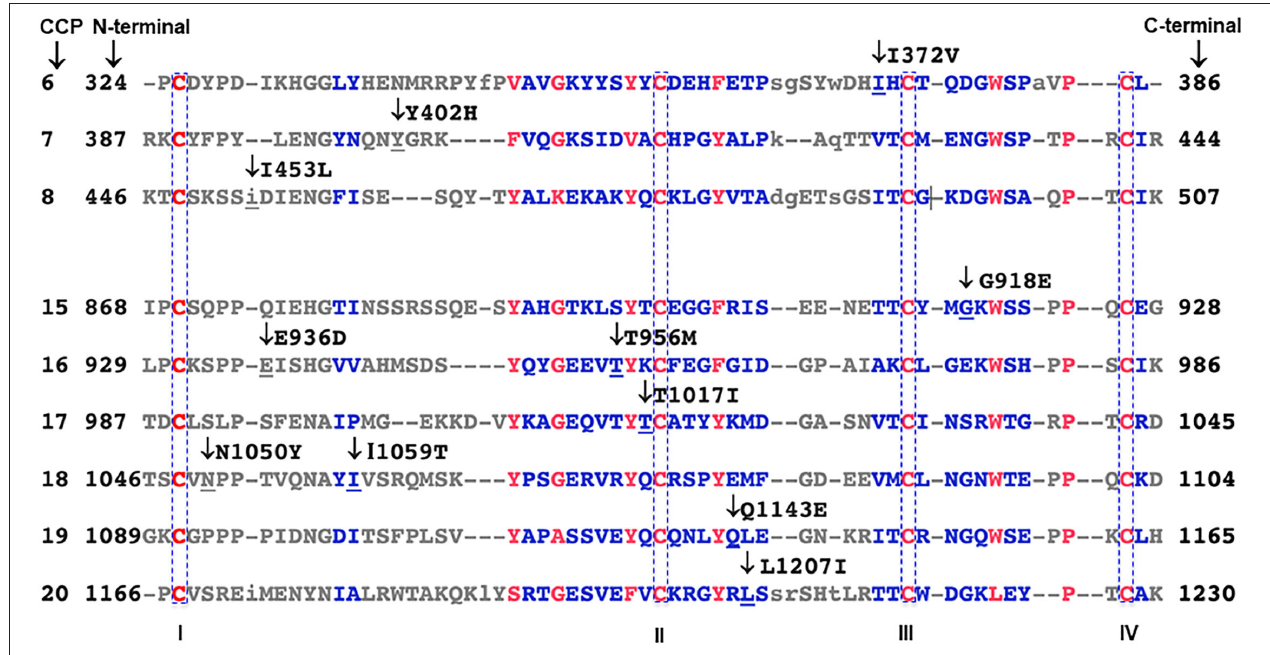
FIGURE 3 | Amino acid sequence alignment of complement control protein (CCP) repeats in FH. Sequence alignments are generated with NCBI protein BLAST software based on position-specific scoring matrix (PSSM). Red to blue color scale represents the degree of conservation; red represents highly conserved residues; blue represents less conserved residues. Upper-case residues are aligned, lower-case residues are unaligned. Mutated residues of FH in the cohort are indicated with arrows. Two disulfide bonds form in each CCP, one between cysteine I and III and the other between cysteine II and IV (red and